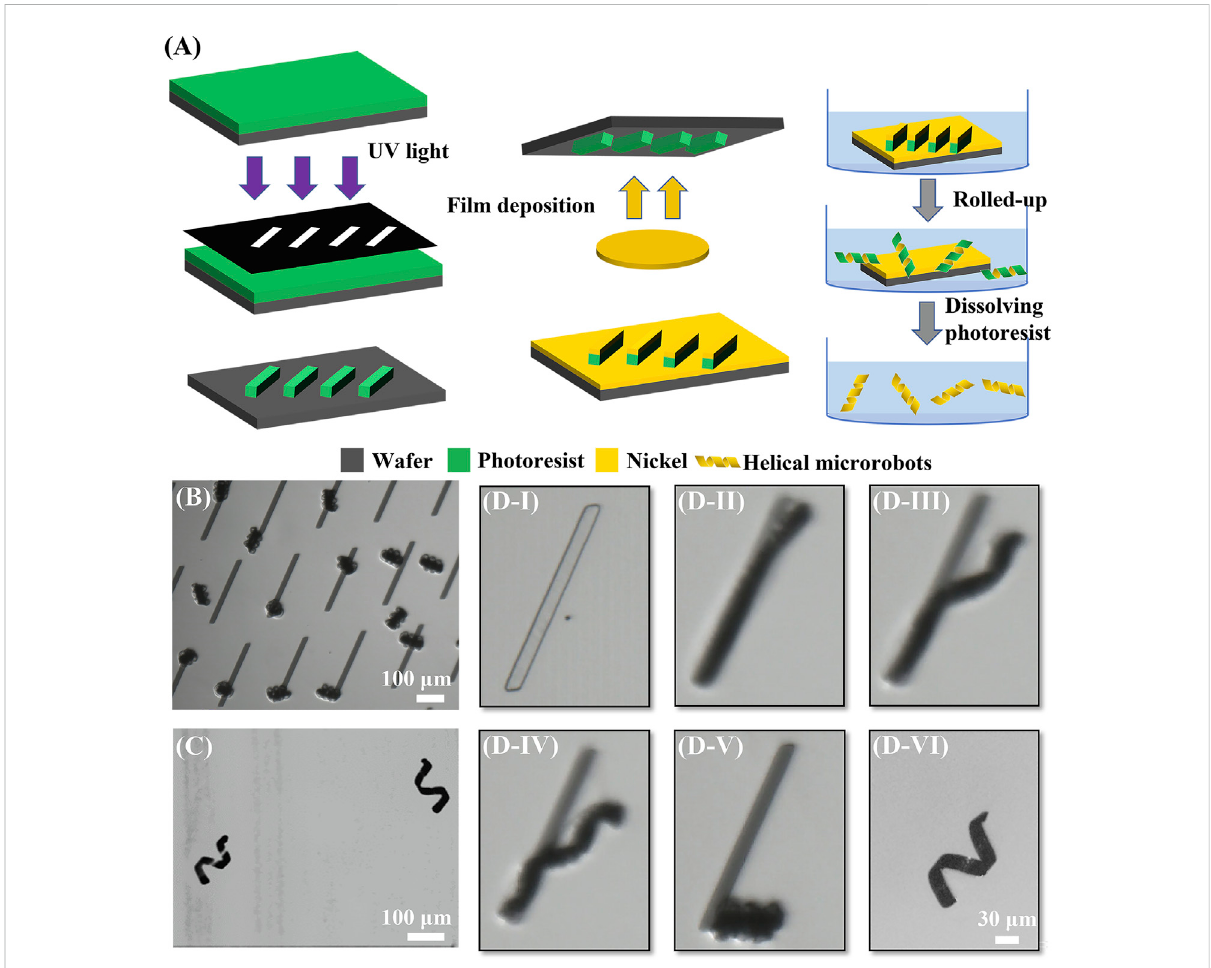
FIGURE 1 Fabrication procedure of helical microrobots. (A) Schematic diagram of the fabrication procedure. (B) Image of coils after rolling. (C) Image of helical microrobots via an optical microscope. (D) Microscope images of the rolled-up process. (D – I) 2D pattern after physical vapor deposition; (D-II) beginning of the rolled-up process when photoresist began to swell and one tip began to lift; (D-III) rolling up along the long edge and the othertipbegantorollup; (D-IV) thetwotipsrolledupfromopposingsidesandmetatthepointofstrongestinterfacialadhesion; (D-V) rolledup into a coil as swelling completes; (D-VI) coil loosened into helical microrobot after the removal of photoresist sacri fi cial